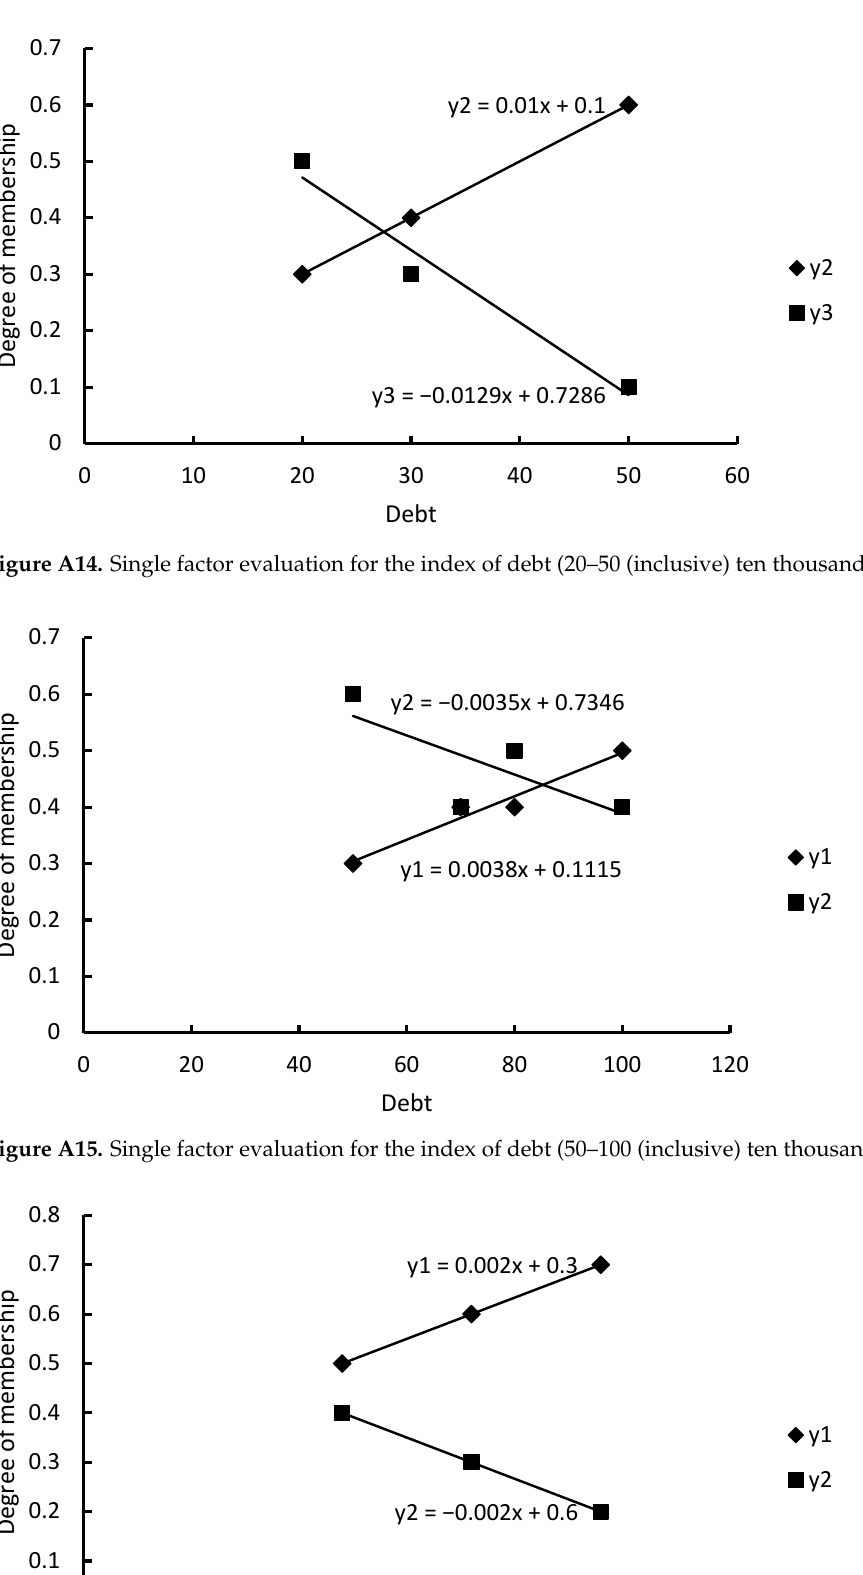
Figure A13. Single factor evaluation for the index of debt (0–20 (inclusive) ten thousand yuan).